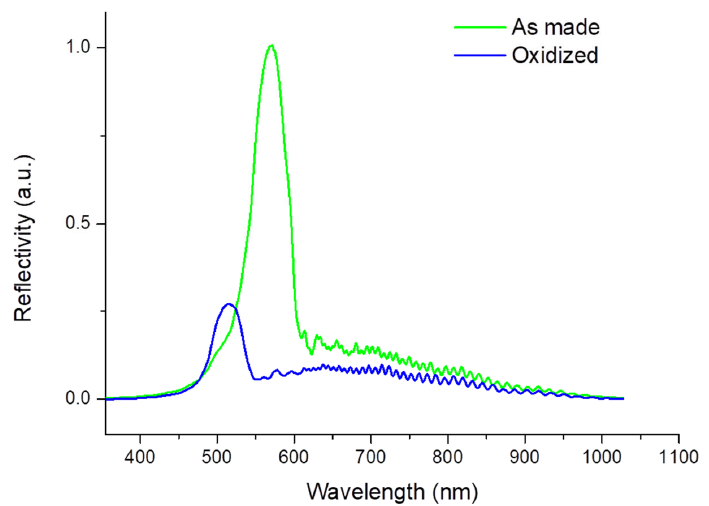
Figure 2. RIfS spectra of pSiRF in air at 23 °C before (green) and after (blue) thermal oxidation in air at 600 °C for 1 h.